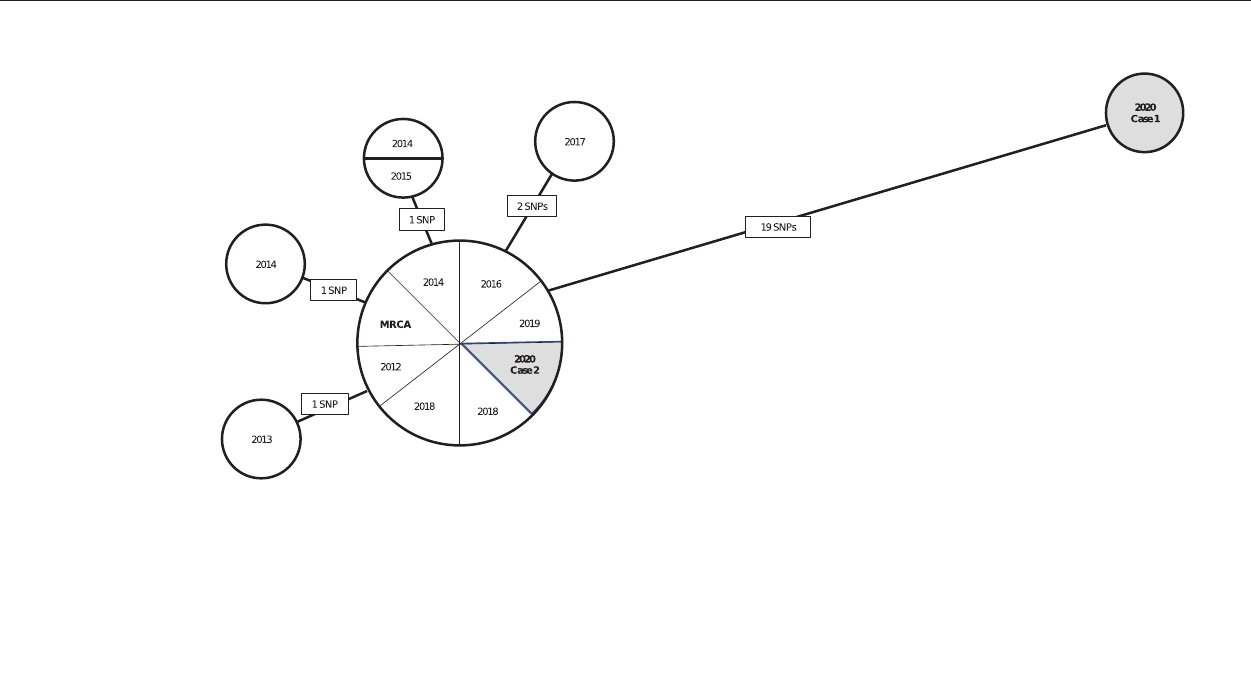
FIGURE 1 | A hypothetical neighbor-joining tree (phylogenetic analysis) representing the genetic distances in single nucleotide polymorphisms (SNPs) among 15 isolates of Mycobacterium tuberculosis ( Mtb ) from culture-confirmed tuberculosis cases reported during 2010–2020 a . a Isolates are displayed as circles called nodes ; isolates with the same genome sequence are displayed together in one node. Lines between nodes are labeled with the number of SNPs (mutations at a single position in the DNA sequence), and these lines are proportional in length to the number of SNPs. The most recent common ancestor (MRCA) is a hypothetical genome (not an actual isolate) from which all isolates in the phylogenetic analysis are descended. The MRCA serves as a reference point for examining the direction of genetic change. In this hypothetical scenario, a TB control program is using these phylogenetic analysis results to help determine if isolates from two patients reported during 2020 (shaded in gray) are likely attributable to recent transmission. If so, those cases are a priority for further investigation. Interpretation of these results, depending on if the Mtb mutation rate is assumed to be similar during latency or to be slower, is as follows: Case 1 is unlikely to be involved in recent transmission under either assumption because the patient’s isolate is genetically distant to that of the patient in Case 2 and all other cases in the analysis ( ≥ 19 SNPs). This interpretation might change as new cases are reported and added to the phylogenetic analysis. Case 2 is more challenging to interpret: under an assumption that Mtb mutates at a similar rate during latent infection and disease, Case 2 is likely to be involved in recent transmission because the patient’s isolate is genetically close to those of other cases in the analysis (0–2 SNPs). If Case 2 was attributable to reactivation after Mtb infection during the remote past, more SNPs can be expected. Under an assumption that Mtb mutates at a slower rate during latency than disease, Case 2 might be involved in recent transmission or attributable to reactivation after Mtb infection during the remote past because relatively few SNPs are expected to accumulate during latency. Other clinical and epidemiologic data are needed for making a